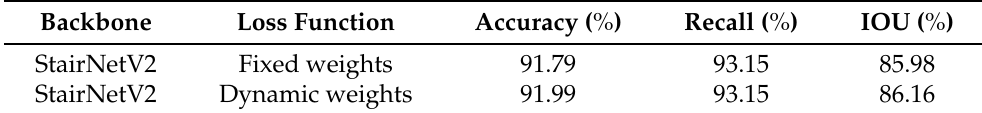
Table 3. Ablation experiment results of the loss